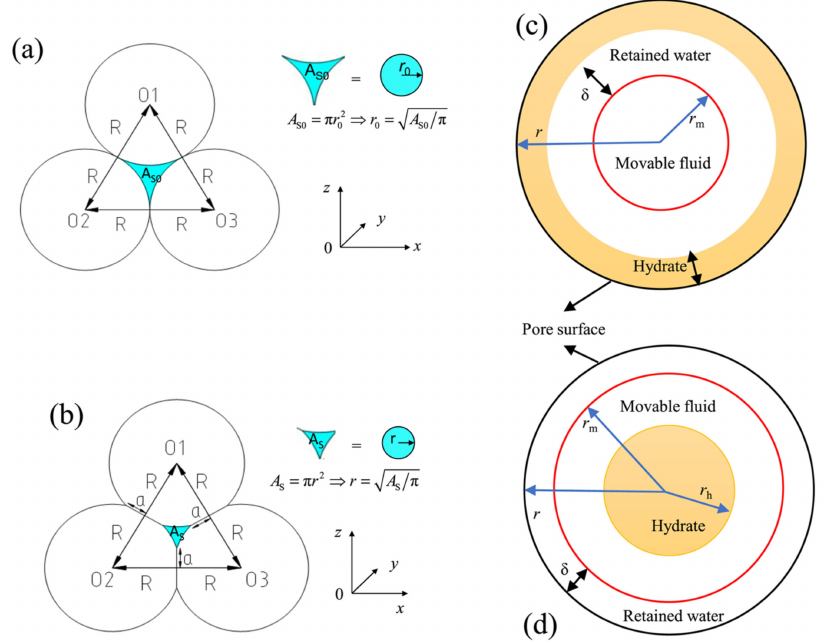
Figure 36. Schematic diagram of two hydrate pore habits in the pore under stress condition reprinted from [71] with permission from Elsevier. ( a ) Pore under zero stress condition; ( b ) pore deformation under normal stress; ( c ) wall-coating hydrates in the pore; ( d ) pore-filling hydrates in the